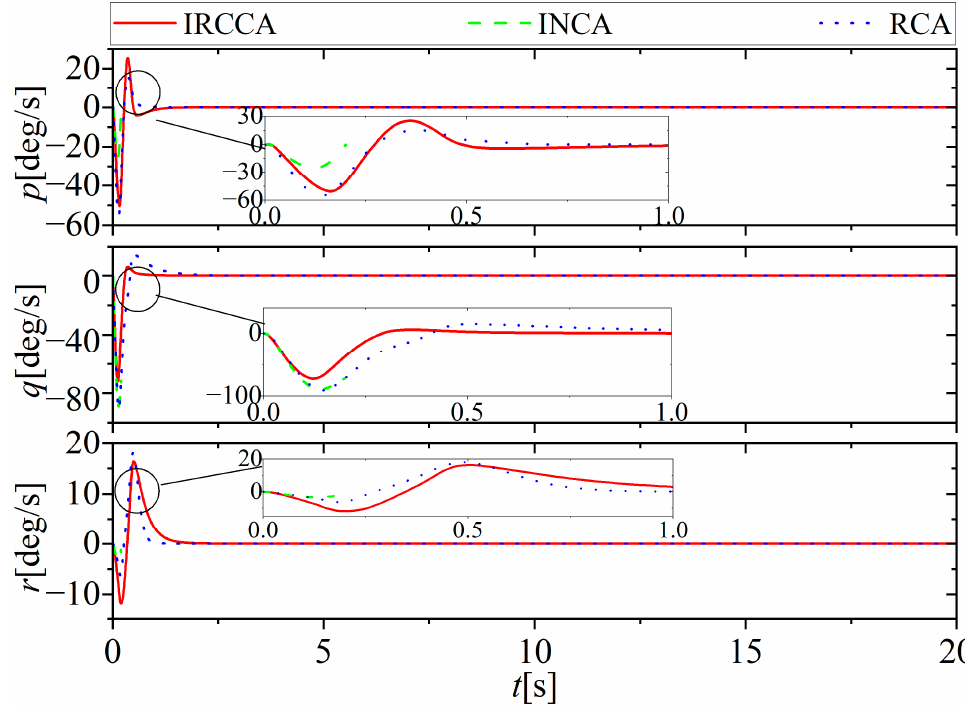
Figure 18. Time response of the attitude angle rate with multiple faults.